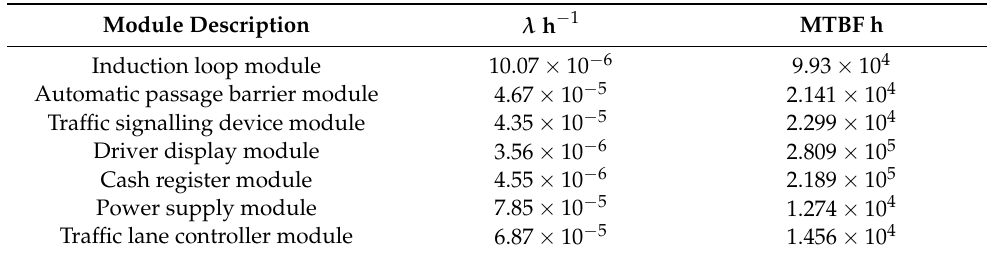
Table 1. Predicting the reliability parameter values for modules of a manual toll collection system station. Source: own study based on [14].